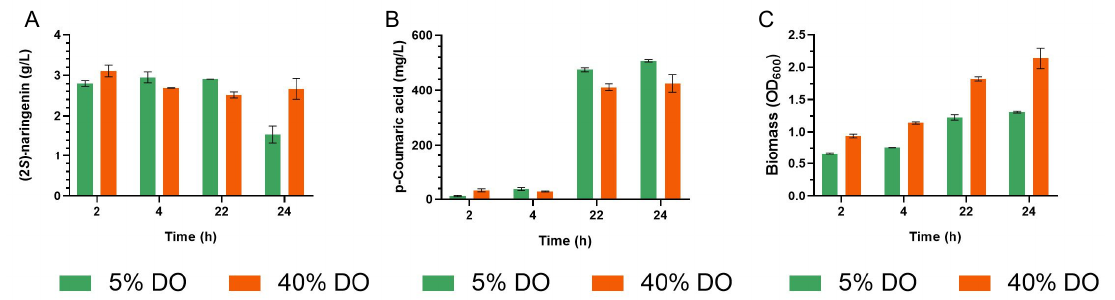
Figure 3. The (2 S )-Naringenin heterologous production at scale pilot. ( A ) The (2 S )-naringenin heterologous production in E. coli . ( B ) The p-Coumaric acid heterologous production in E. coli . ( C ) Cell growth of E. coli . The green bars represent the 5% oxygen dissolved condition. The orange bars the 40% oxygen dissolved condition.